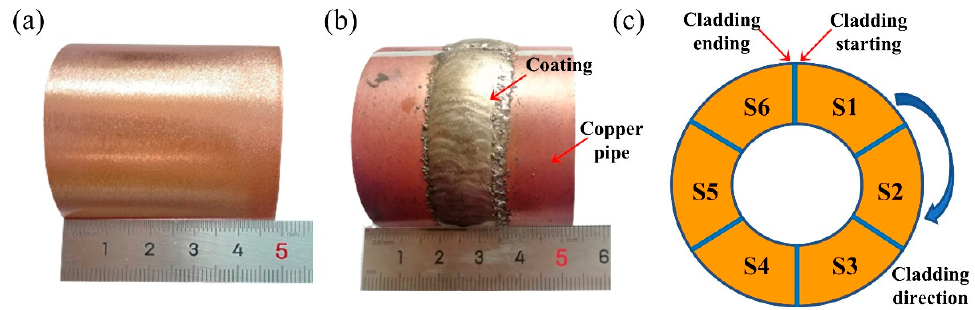
Table 1. Chemical composition (wt.%) of the Ni60A powder.